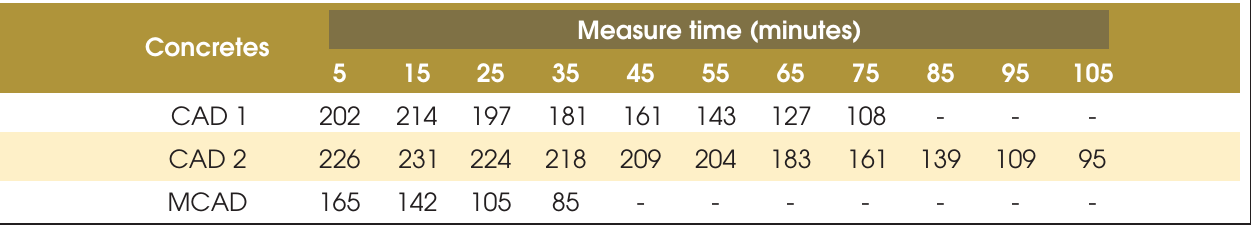
Table 17 – Slump values obtained by the modified slump test as a function of time for the tested concretes